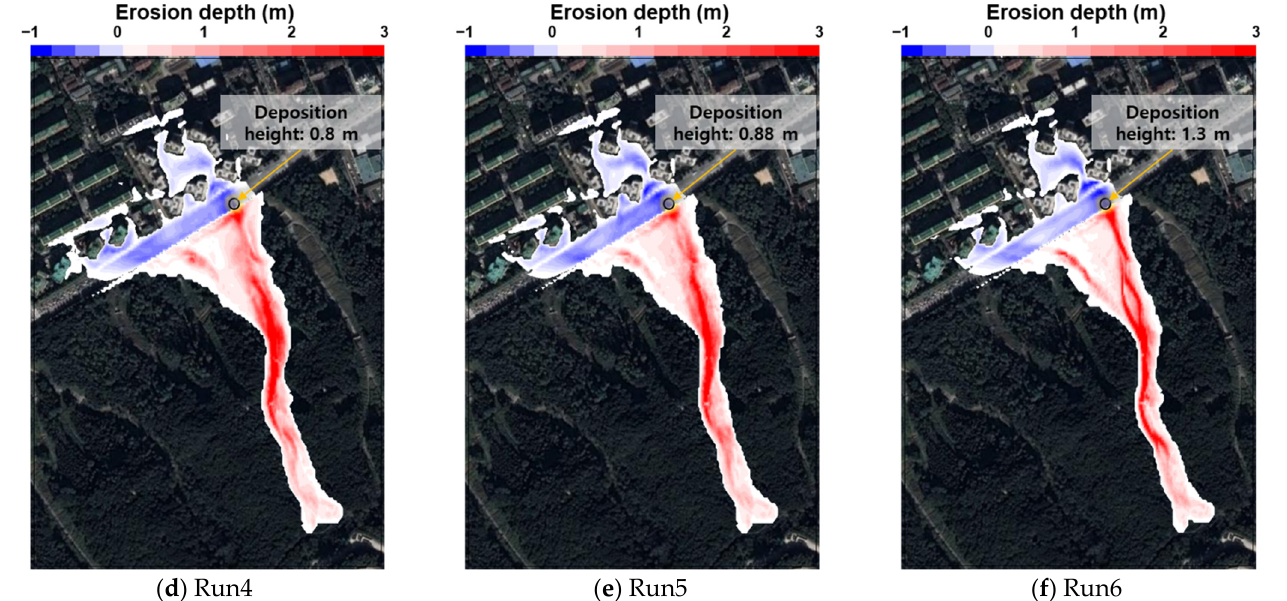
Figure 8. Final spatial pattern of entrainment erosion in all the simulations.